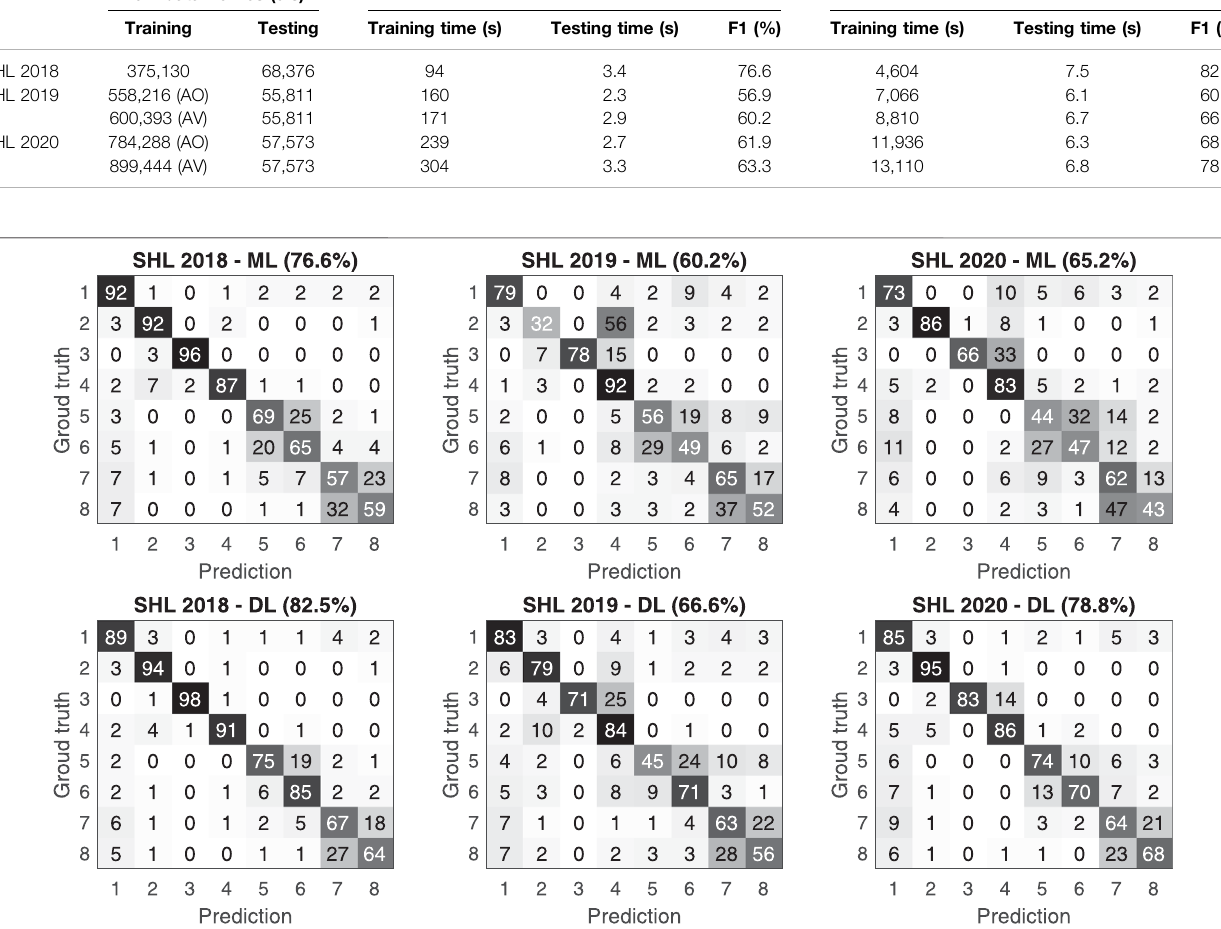
Frontiers in Computer Science |